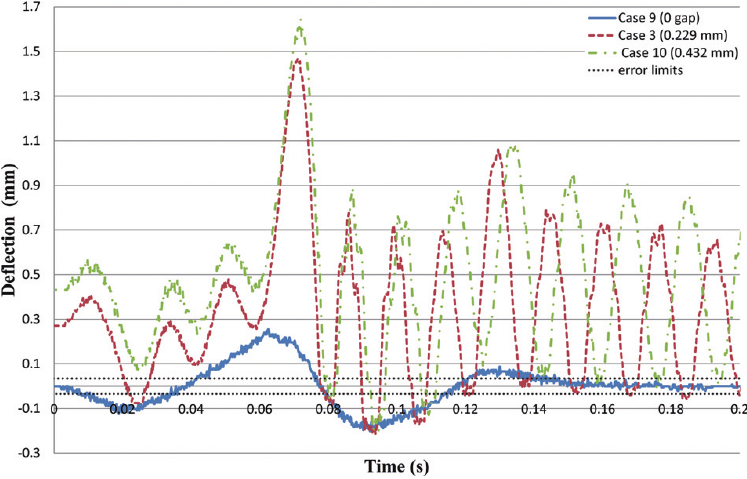
Fig. 6. Comparison of changing gap